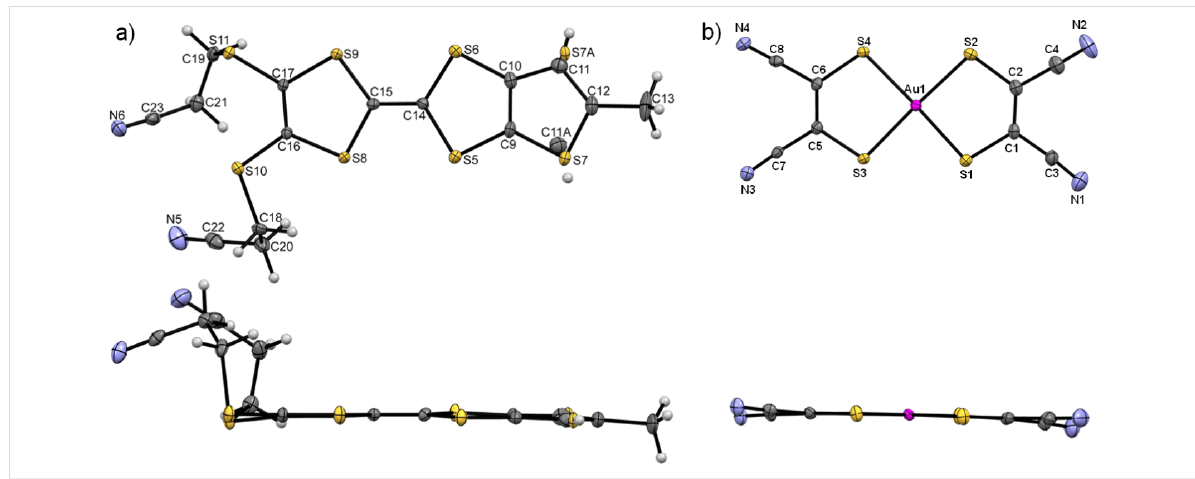
terminal thiophenic ring, with occupation factors of 55% and 45% for S7 and S7A, respectively. The [ α -mtdt] + cation is almost planar, with exception of the –(CH 2 ) 2 –CN groups, that point out in the same direction (Figure 7). In both donor and acceptor units, the bond lengths are within the expected range, oxidised TTF donors [18], namely the Au–S and